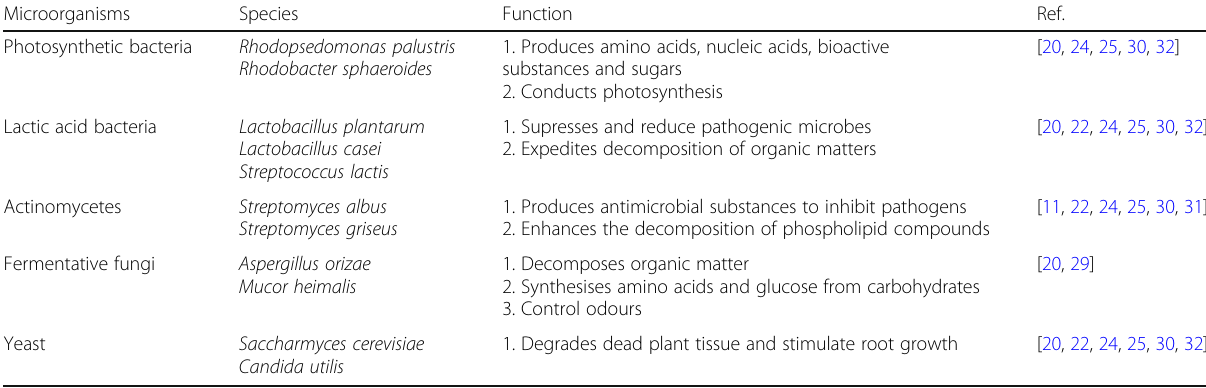
Table 5 Various EMs for formulation Microorganisms Ref.